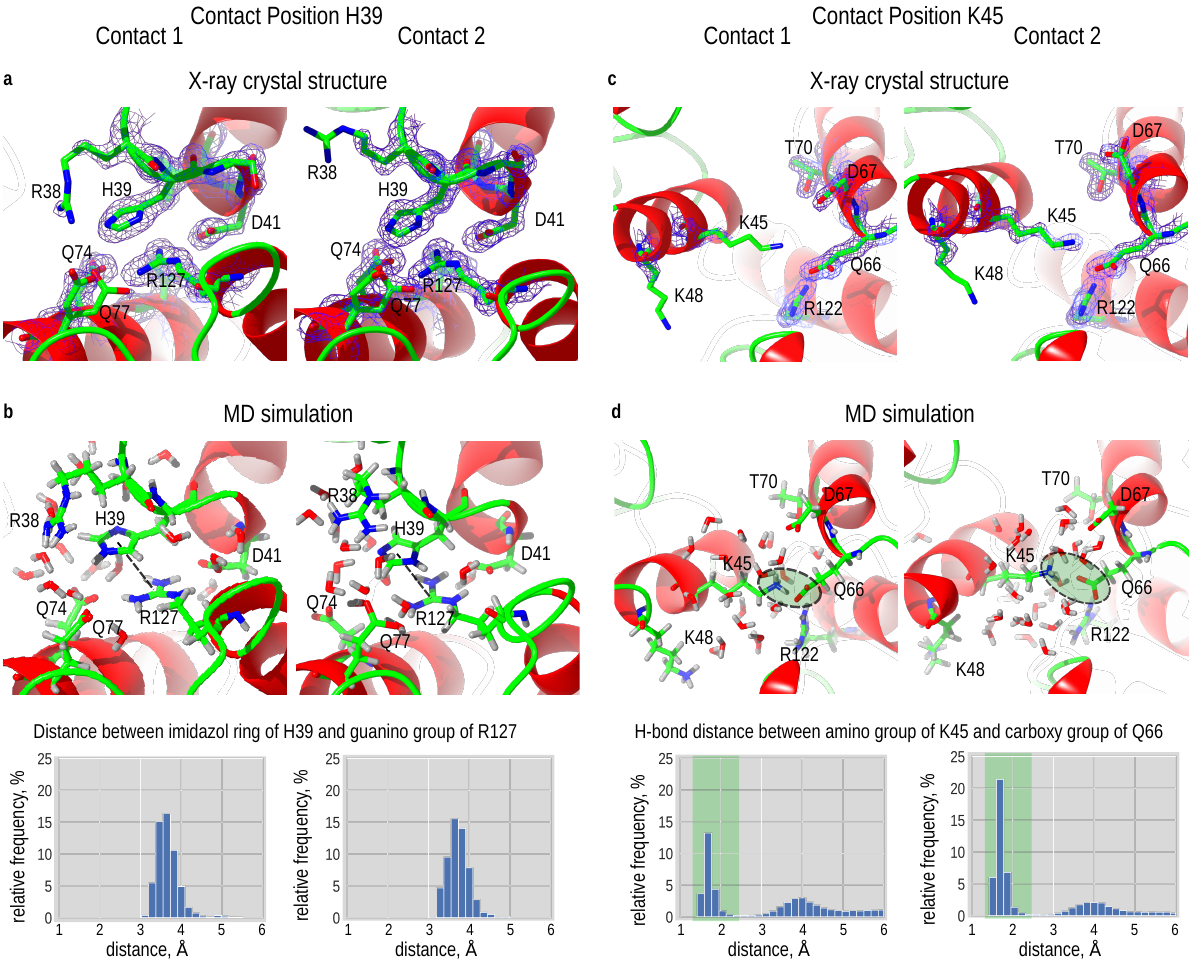
Figure 6. X-ray crystallography structure and MD simulation analysis of corner contact 1 and 2 around H39 and K45 for wild type crystals. ( a ) X-ray crystallography structure of crystal contact around H39. Relevant nearby residues are displayed with measured electron density shown in blue. ( b ) Snapshot from MD simulation trajectory including nearby water molecules and analysis of the center of geometry (COG) distances between imidazole ring of H39 and guanino group of R127. The average binding distance is 0.37 ± 0.03Å in both cases. ( c ) X-ray crystallography structure of crystal contact around K45. Relevant residues are displayed with measured electron density shown in blue. ( d ) Snapshot from MD simulation trajectory including nearby water molecules and analysis of the minimum distance between the positive amino group of K45 and negative carboxy group of Q66 (circled in green). Distance values in H-bond distance (<2.5Å) (dyed in green) occurred for 39.5 ± 8.0% (contact 1) and 64.0 ± 8.5% (contact 2) of the time. Electron density maps are calculated with structure factor amplitude difference 2F o − F c and contoured at 1.0 σ